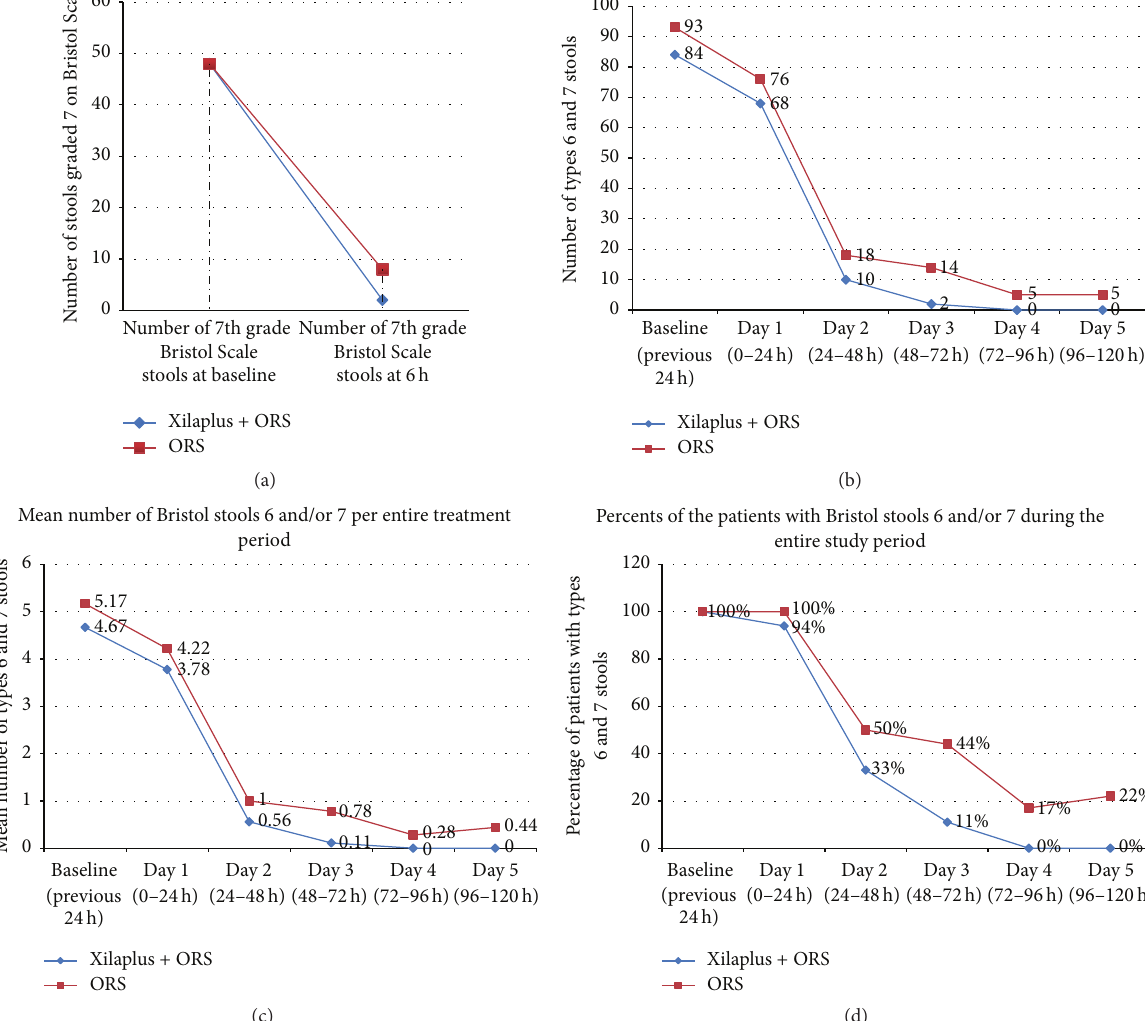
Figure 1: Evolution of types 6 and 7 Bristol Scale stools in both groups. (a) Evolution of the absolute number of type 7 stools during the first 6 hours. (b) Evolution of absolute number of types 6 and 7 stools during the study period. (c) Evolution of mean number of types 6 and 7 stools during the study period. (d) Evolution of the percentage of patients with types 6 and 7 stools during the study